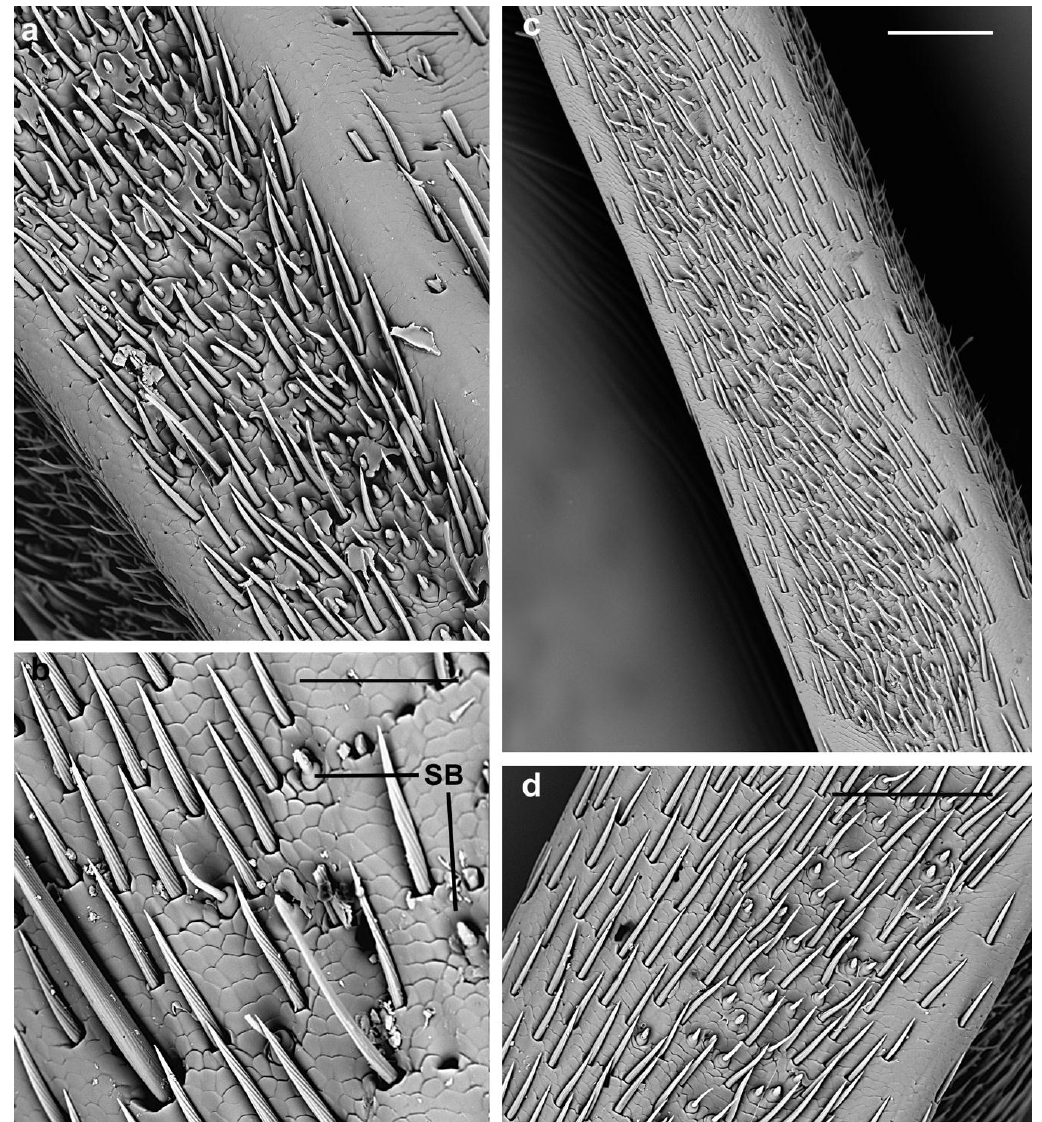
Figure 12. A. bungii male, SEM. Sensilla basiconica. ( a ) Numerous SB1 and SB2 concentrated in one lateral band. ( b ) Detail of few SB visible elsewhere outside the lateral bands. ( c ) Ventral view of the ninth flagellomere with a few basiconica not covering the entire surface as in females. ( d ) Overview of few SB in the basal region of a flagellomere showing a lower concentration compared with A.